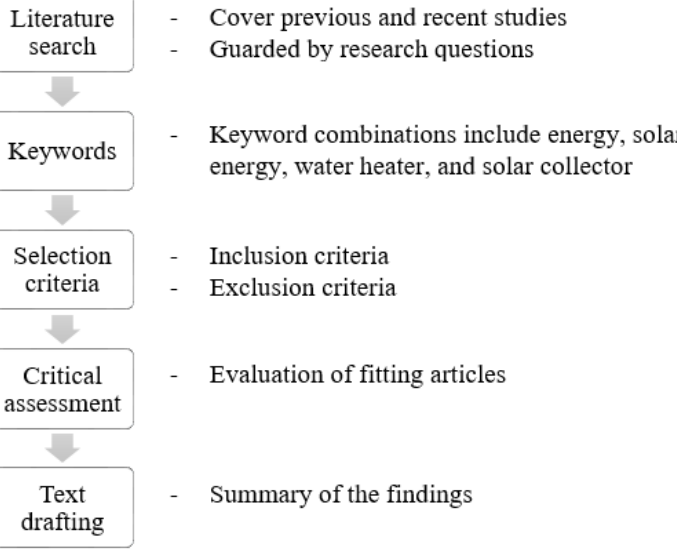
Figure 1. The 5-step process of the narrative review [18].